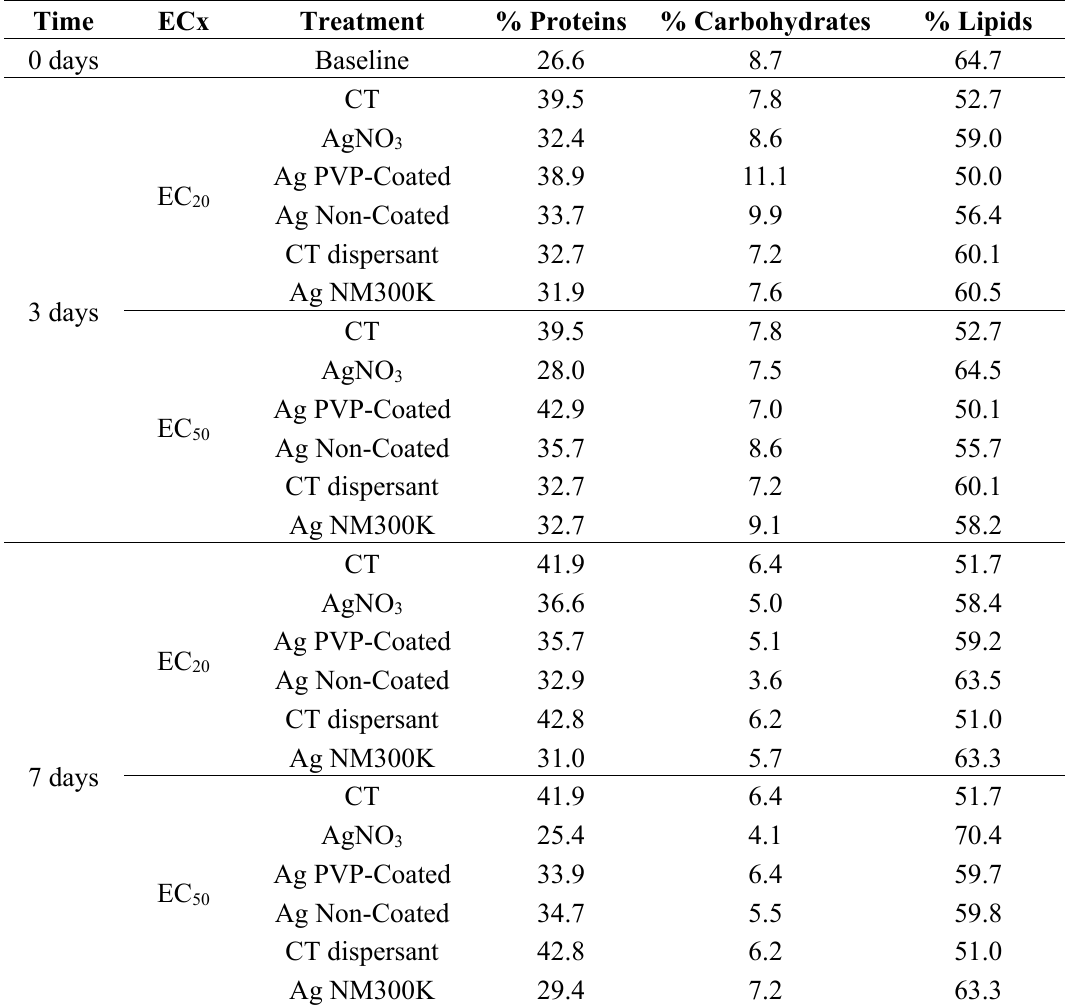
Table A2. Proportion (%) of energy reserves available (proteins, carbohydrates and lipids) in Enchytraeus crypticus after exposure to the concentrations of effect on reproduction EC 20 and EC 50 of silver nitrate (AgNO 3 ) and three silver nanoparticles: Ag PVP-Coated, Ag Non-Coated and Ag NM300K for 0 days (Baseline), 3 and 7 days. CT: